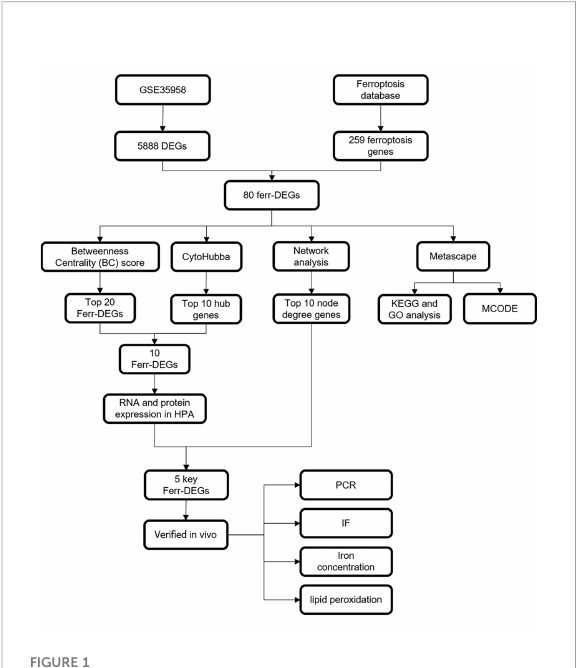
FIGURE 1 Schematic diagram showing the study